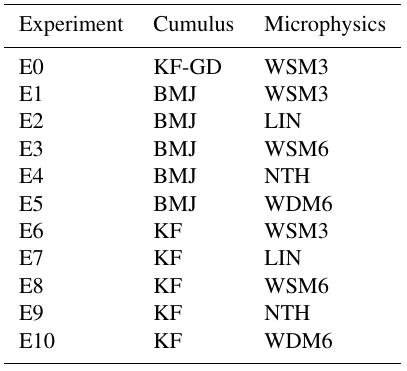
Figure 1. Basque Country, River basins and rain-gauge location (red and blue points).